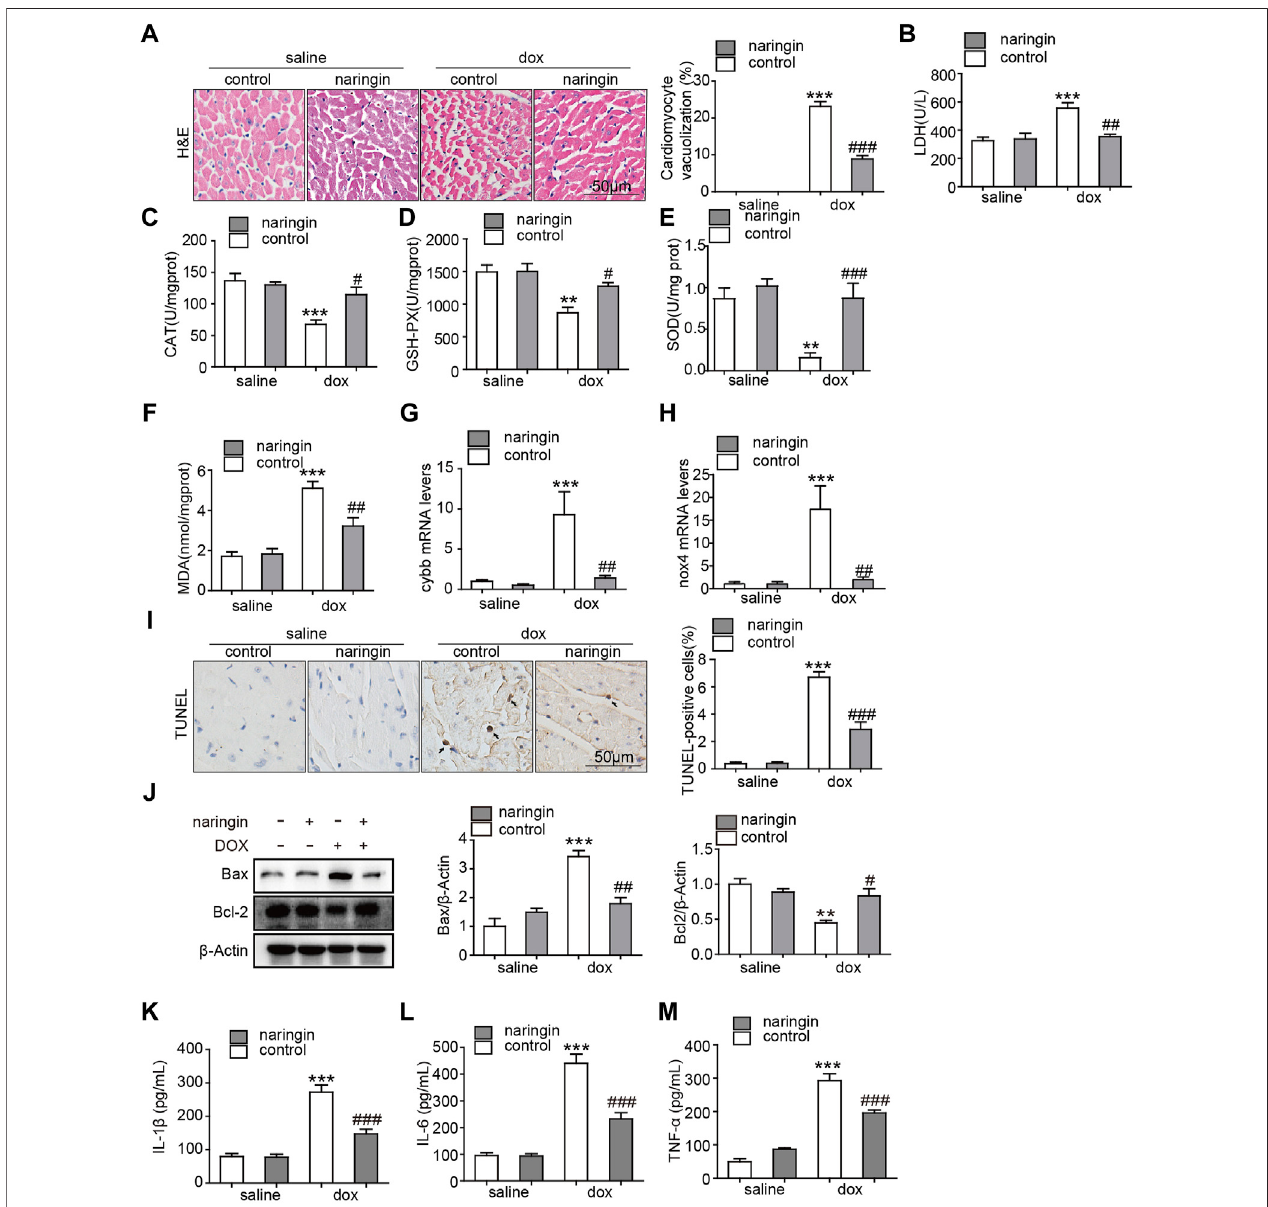
FIGURE 3 | Naringin inhibits the effect of DOX on apoptosis, in fl ammation and Oxidative stress in vivo (A) Naringin protects heart from vacuolization induced by DOX. H&E staining of heart sections (left panel), with quanti fi cation analysis (right panel). (B) The content of LDH (lactic acid dehydrogenase) activity in cardiac. (C) The contentofCAT activity incardiac. (D) ThecontentofGSH-PXactivity incardiac. (E) ThecontentofSOD activityincardiac. (F) ThecontentofMDA activity incardiac. (G) Cardiac mRNA expression level of cybb was measured by qPCR analysis. (H) Cardiac mRNA expression level of nox4 was measured by qPCR analysis. (I) Mice heartsectionswereconductedTUNELstainingfordeterminationofapoptotic cells(blackarrowsindicateTUNELpositivecells,leftpanel)withquanti fi cationofapoptotic cellswithquanti fi cationanalysis(rightpanel). (J) TheexpressionofBax,Bcl-2and β -actindetectedbyWesternBlot. (K – M) ThelevelofIL-1 β ,IL-6andTNF- α detectedby ELISA. *** p < 0.001 DOX versus control group; ## p < 0.01, and ### p < 0.001 DOX versus NR + DOX.